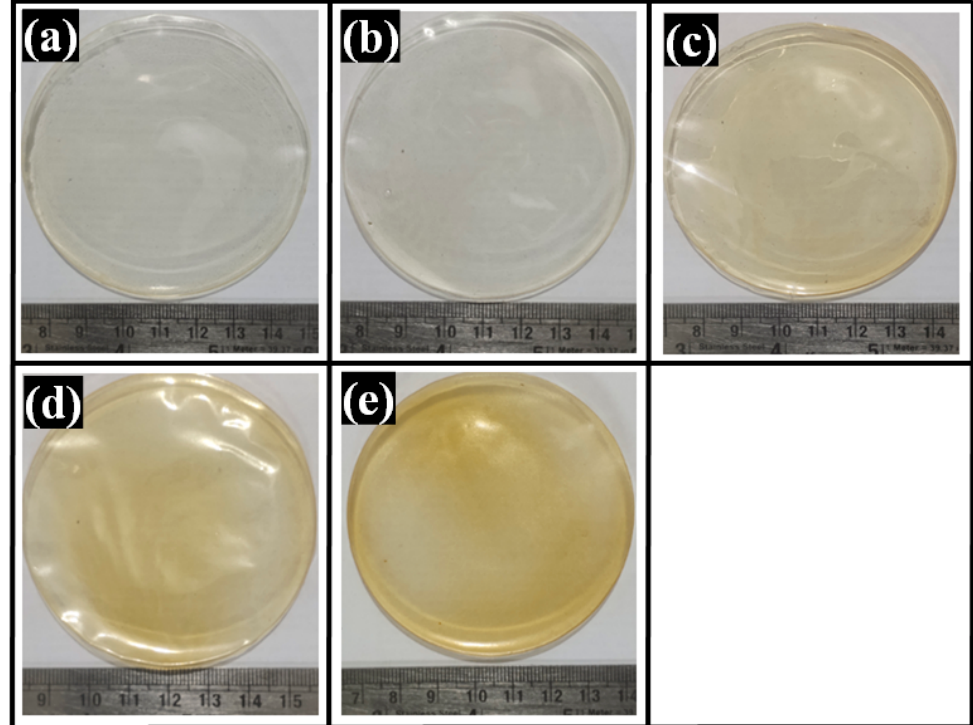
Figure 1. Pictures of the films: ( a ) F0, ( b ) F1, ( c ) F2, ( d ) F3, and ( e ) F4.